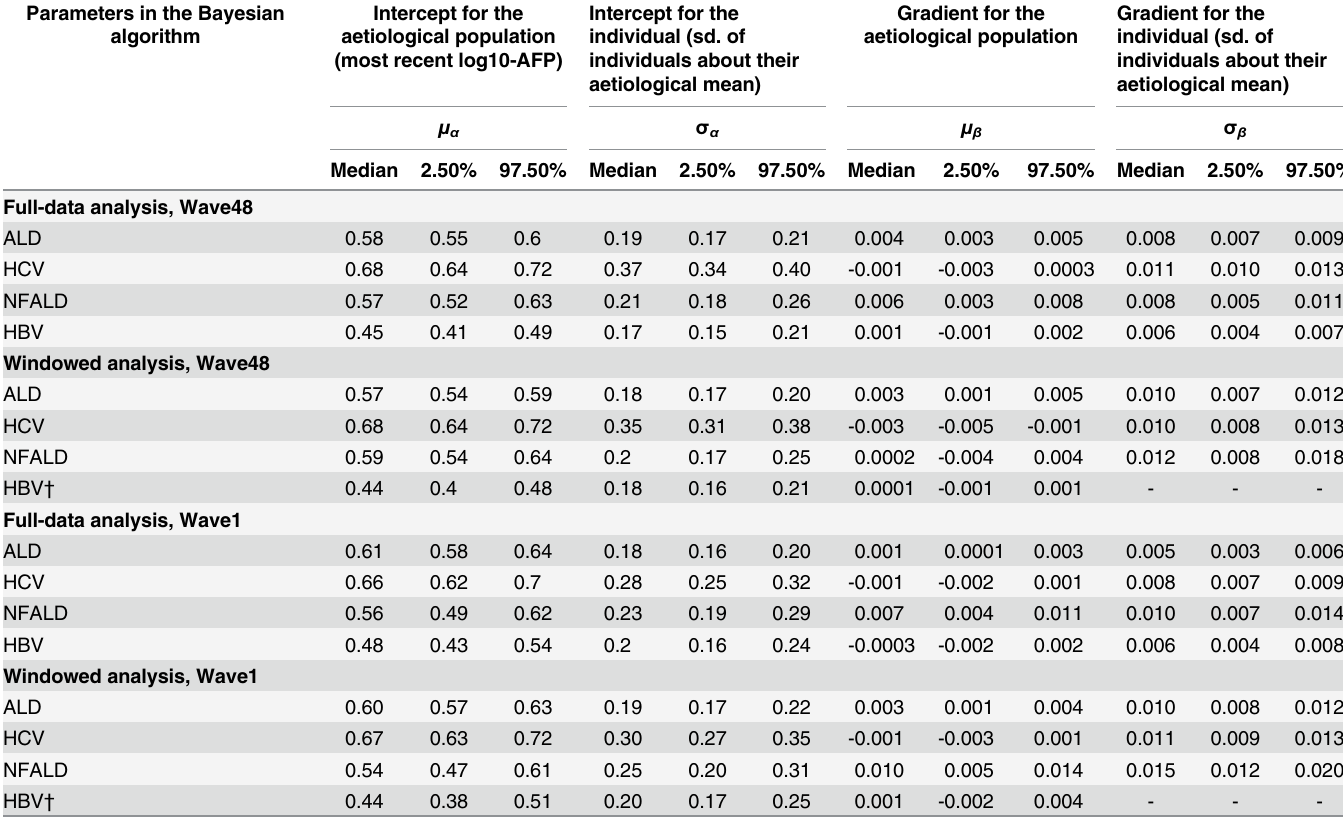
Table 3. Model coefficients obtained from full-data and windowed analyses in static mode (wave 48) and dynamic mode (wave 1). Parameters in the Bayesian Intercept for the algorithm aetiological population